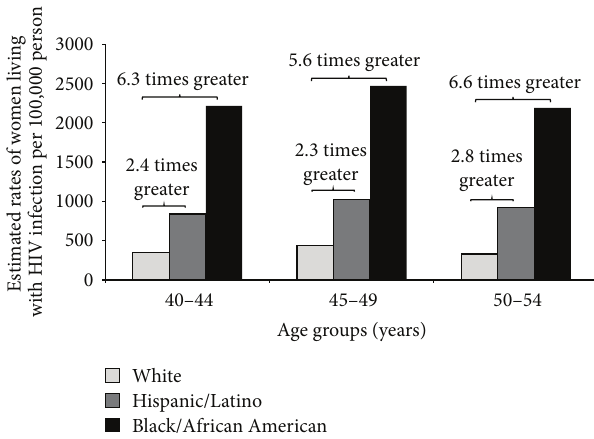
Figure 2: Estimated rates of women living with HIV infection, by age groups, 40–44, 45–49, and 50–54 years, among all women, by race/ethnicity in 46 states, United States, 2011. Estimates were calculated based on data provided in